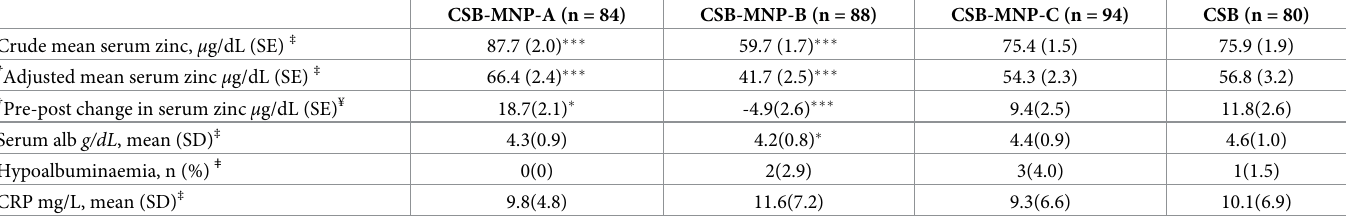
Table 3. Post-intervention serum zinc, albumin and CRP concentration by study